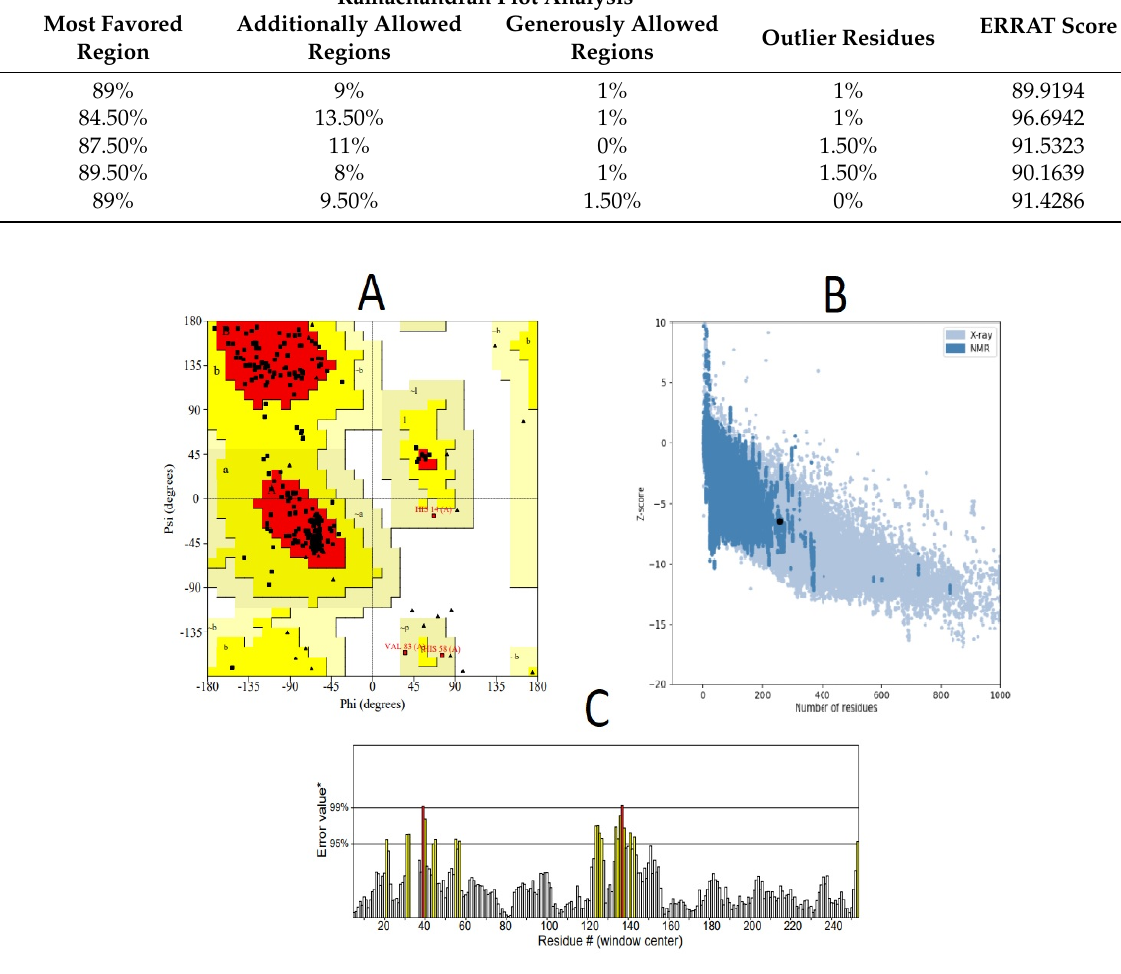
Figure 3. Structural evaluations of the modeled multi-epitope vaccine confirmed its high quality and stability using ( A ) Ramachandran plot analysis. It was confirmed that a total of 89% of the modeled residues resided in the most favored red region (indicated by capital letters A, B) whereas 9.5% and 1.5% residues resided in the additionally allowed bright yellow regions (indicated by small letters a, b) and generously allowed light yellow regions (indicated by ~a, ~b) respectively. Outlier regions are those having white background color. Glycine residues are indicated by triangles. ( B ) Prosa quality check confirmed that the modeled structure’s quality lies within the range of similar experimentally resolved NMR structures, with a Z-score of − 6.47. ( C ) Stereochemical check by the ERRAT server revealed a high ERRAT score of 91.4286 that signifies that a good quality refined structure was obtained. On the error axis, two lines are drawn to indicate the confidence with which we can reject the regions that exceed that exceed that error value. Regions that have greater than 95% error are indicated by yellow color, whereas in rare cases residues having greater than 99% error values were found, indicated by red